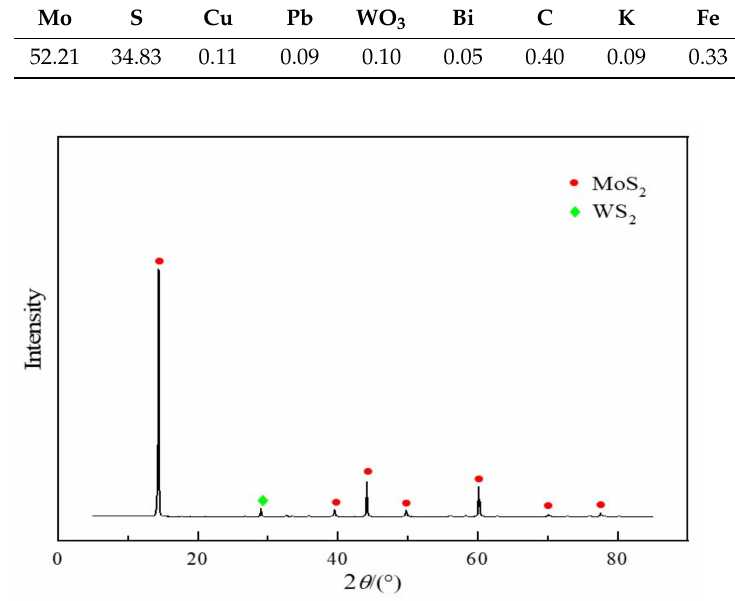
Figure 1. XRD pattern of the